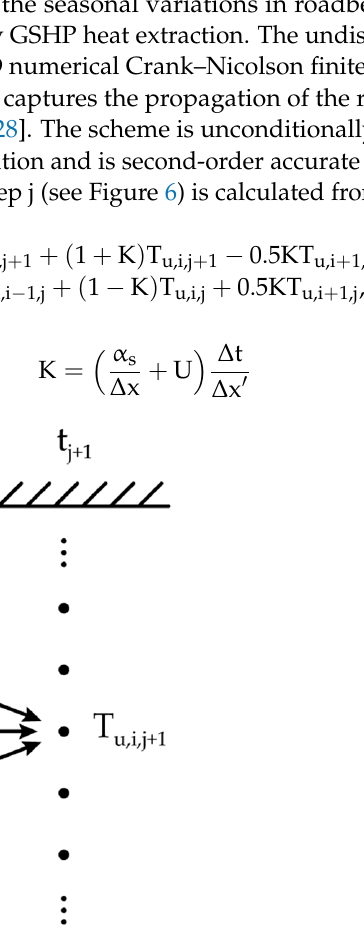
Figure 6. 1D discretization of the subsurface. The temperature at node i is calculated from the temperatures at the node itself as well as both neighbors at the previous timestep.